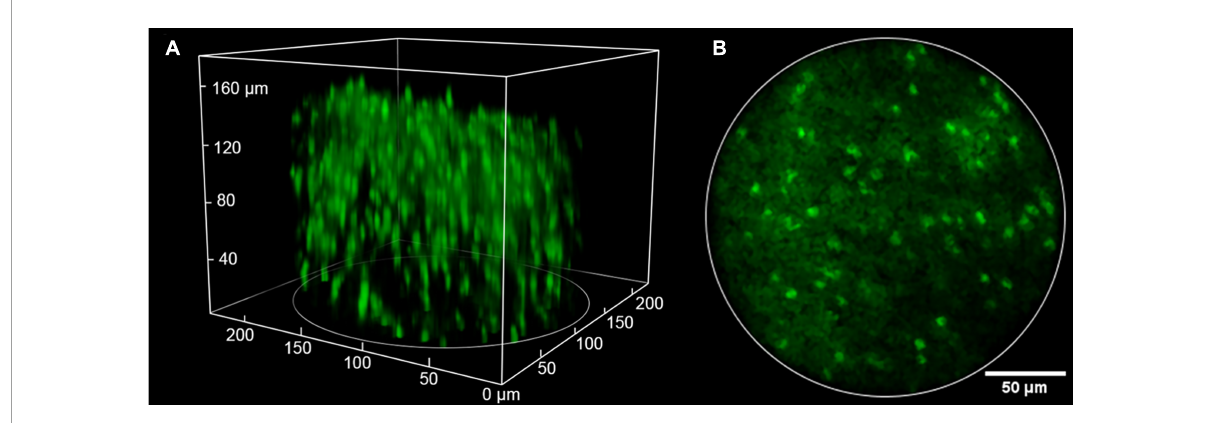
FIGURE6 Typical imaging result of two-photon miniscopes. Reproduced with permission from Ozbay et al. (2018). (A) 3D volume of over 200 GFP-expressing oligodendrocyte cells (220 × 220 µ m lateral × 180 µ m axial). (B) An image from a single slice in the